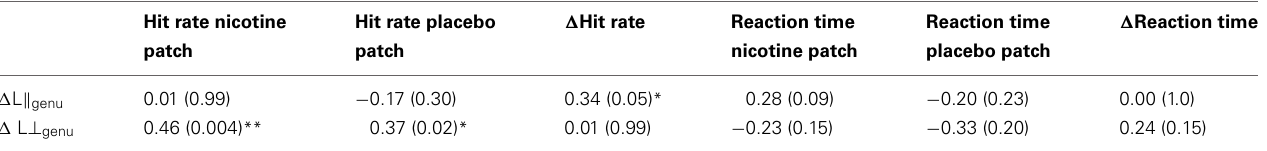
Table 5 | Correlation coefficients for intersession difference in diffusivity values for the genu of corpus callosum and sustained attention hit rate and reaction